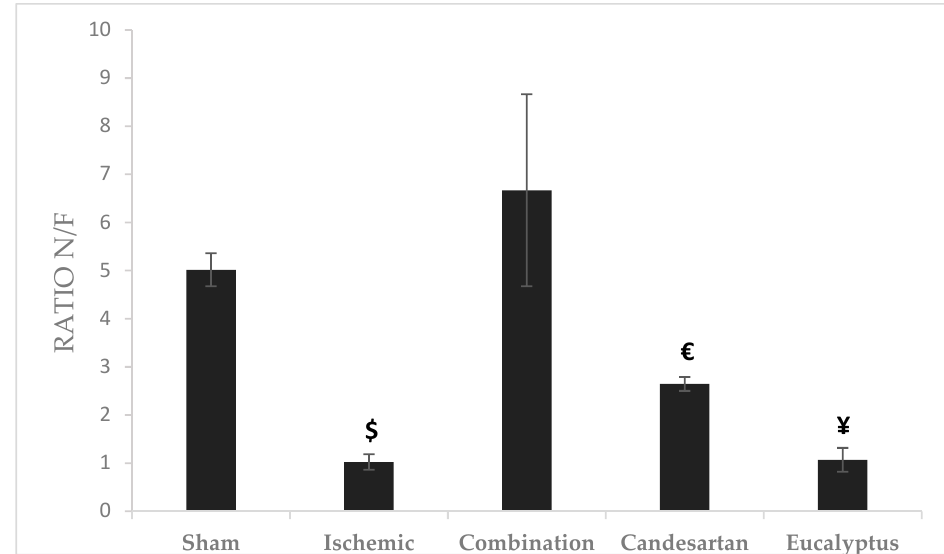
Figure 5. Object recognition test (ORT) results. ORT including novel/familiar (N/F) objects ratio for the time of exploration of a novel object (N) to a familiar one (F) done at D +8 for Sham (n = 6), Ischemic (n = 11), Ischemic treated with a combination of Candesartan and Eucalyptus (n = 10), Ischemic treated with Candesartan (n = 5), and Ischemic treated with Eucalyptus (n = 5) groups. $ p < 0.05 for a significant difference between Ischemic and Ischemic treated with a combination of Candesartan and Eucalyptus ; € p < 0.05 for a significant difference between Ischemic treated with Combination and Candesartan only; ¥ p < 0.05 for a significant difference between Ischemic treated with Combination and Eucalyptus only.